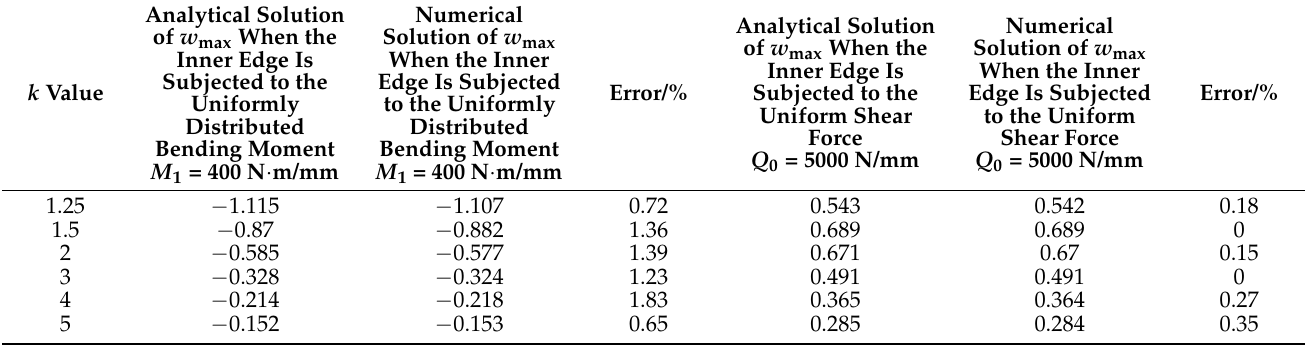
Table 4. Maximum deflection of bending of annular SP-HCs simply supported on the outer boundary with a hole in the center under different k